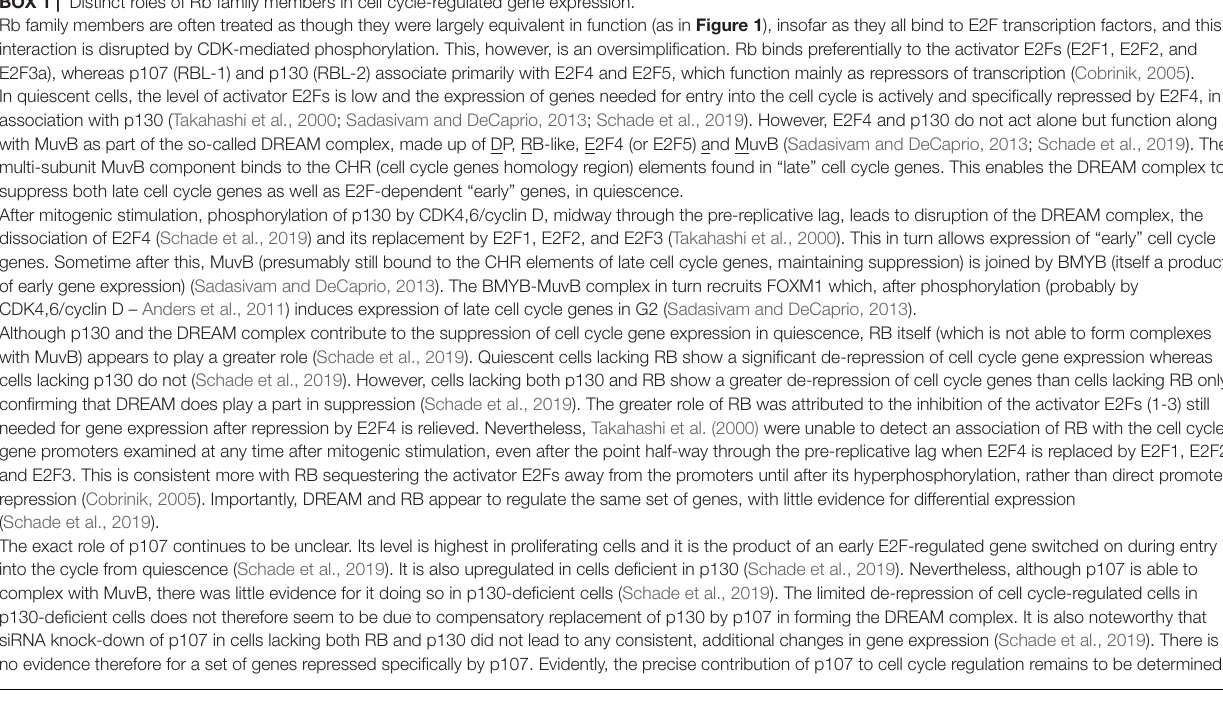
in pathway dynamics around the threshold, due either to small numbers of interacting molecules or to small differences in parameter values resulting from the previous history of the cell